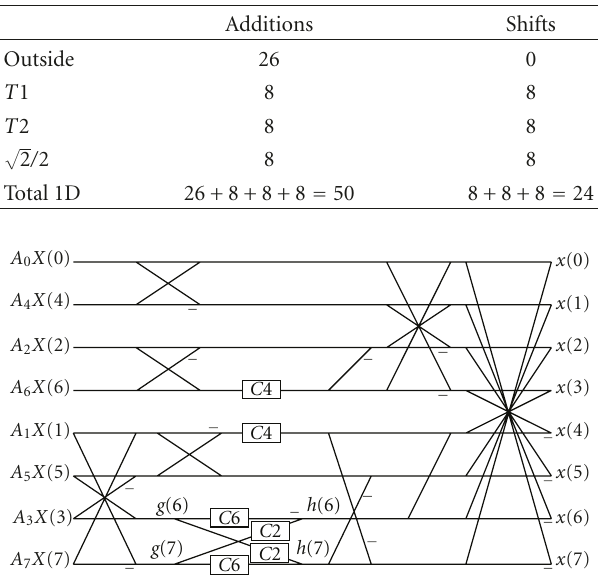
Figure 3: The revised flow graph of AAN based on the character, n = 8 . Table 2: The statistics of computational